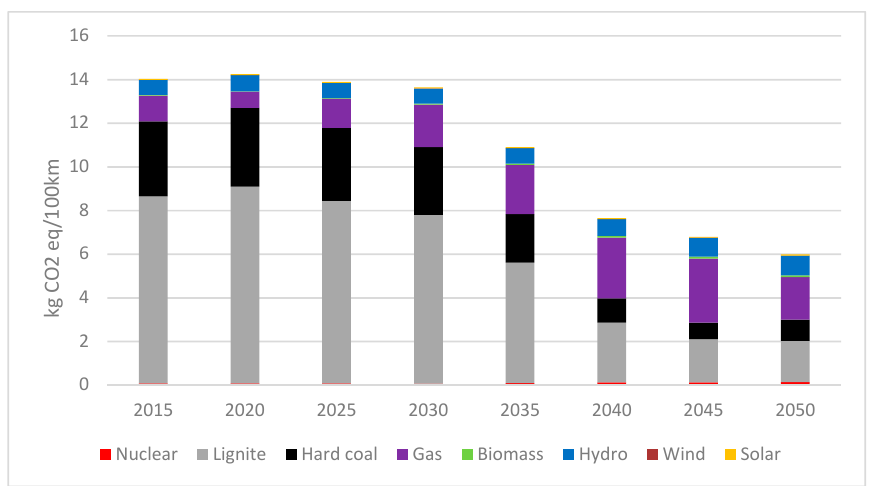
Figure 7. Results of the carbon footprint from electric vehicles batteries charging in the CR.